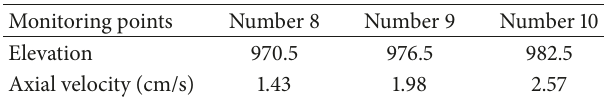
Table 4: Axial peak velocity of different elevation for 6# generator sets in draw cut blasting of deep